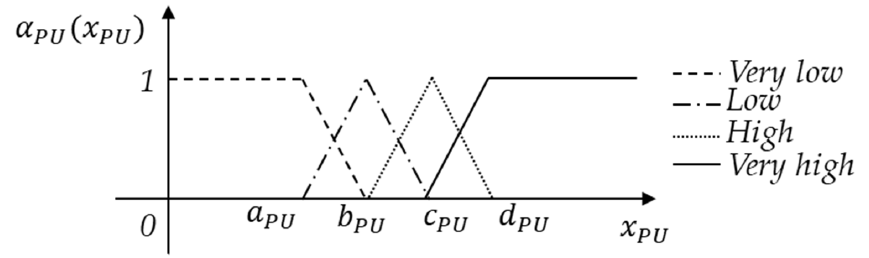
Figure 4. The membership function of the linguistic variable of the sorting point utilisation rate.